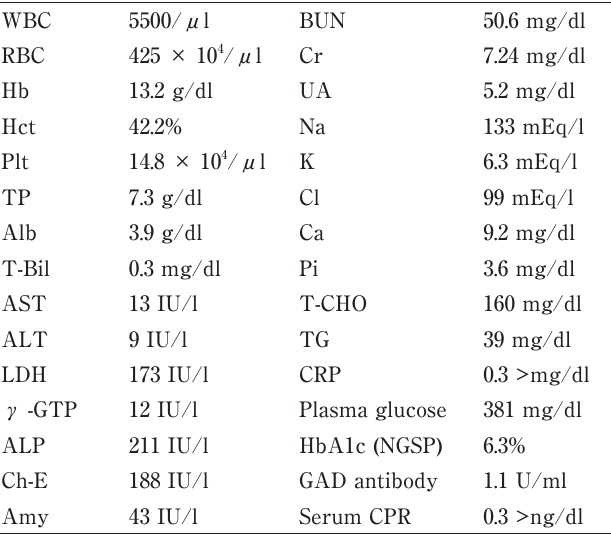
Table 1. Laboratory data on admission